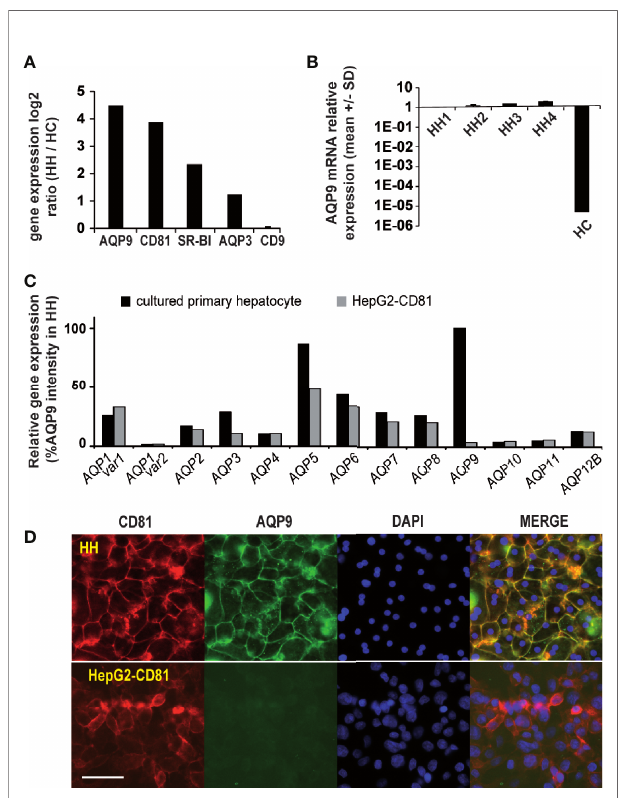
FIGURE 1 | AQP9 and CD81 are expressed at higher levels in P. falciparum permissive human hepatocytes than in refractory hepatoma cells. (A) Transcriptomes of human hepatocytes (HHs) and human hepatoma HepG2- CD81 cells (HCs) were analysed using a 22K pan-genomic human oligo microarray (Agilent Technologies). AQP9, CD81, AQP3 and CD9 gene expression levels are presented as average log2 gene ratios in HH/HC. (B) RT-qPCR analysis of AQP9 mRNA expression in 4 sets of HHs and in HCs. Variations in transcript levels were calculated after normalisation to expression of the TBP gene and are presented relative to the AQP9 mRNA level in HH1. (C) Relative gene expression of aquaporins 1 to 12B in HHs from 3 donors and HCs is presented as the mean % of the AQP9 gene expression level in HHs, determined with the 22K pan-genomic human oligo microarray. (D) Immuno fl uorescence analysis of CD81 and AQP9 expression on HHs (upper panel) and HCs (lower panel). Cells were fi xed, permeabilized, and incubated with a mixture containing a mouse monoclonal antibody against human CD81 and human AQP9 antibody and reacted with the appropriate secondary antibodies conjugated to Alexa 568 and Alexa 488, respectively. The white scale bar represents 100